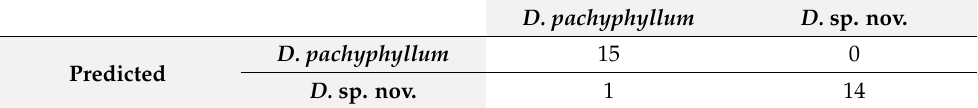
Figure 7. Overall classification error rate from the cross-validation procedure. The number of LVs selected is red-circled. Table 4. Confusion matrix obtained by predicting the independent validation